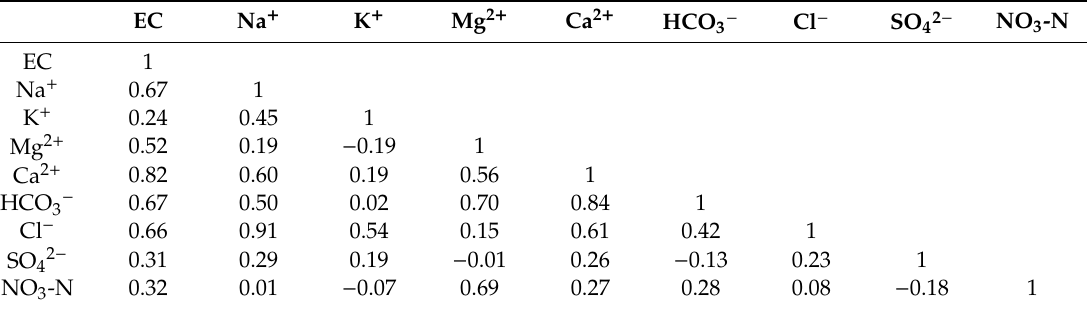
Table 2. Pearson correlation coe ffi cients for EC and major ions of all groundwater samples.